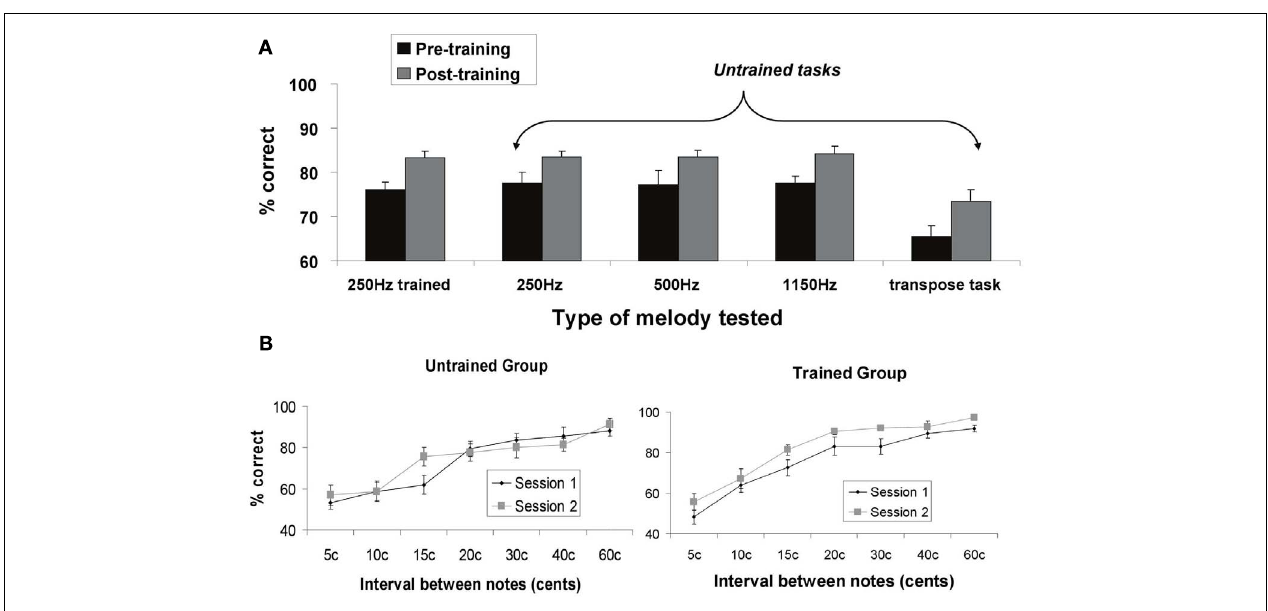
discrimination task in which the second item was transposed to a different pitch level (i.e., 1150Hz).There was significant and comparable improvement in all tasks after training, indicating generalization to new pitch levels and new tasks. (B) Performance on the 250Hz micromelodies before and after training as a function of pitch interval for both the control (untrained) group, and the experimental (trained) group. No change was observed at any pitch level for the control group. Significant improvement was obtained in the trained group across all